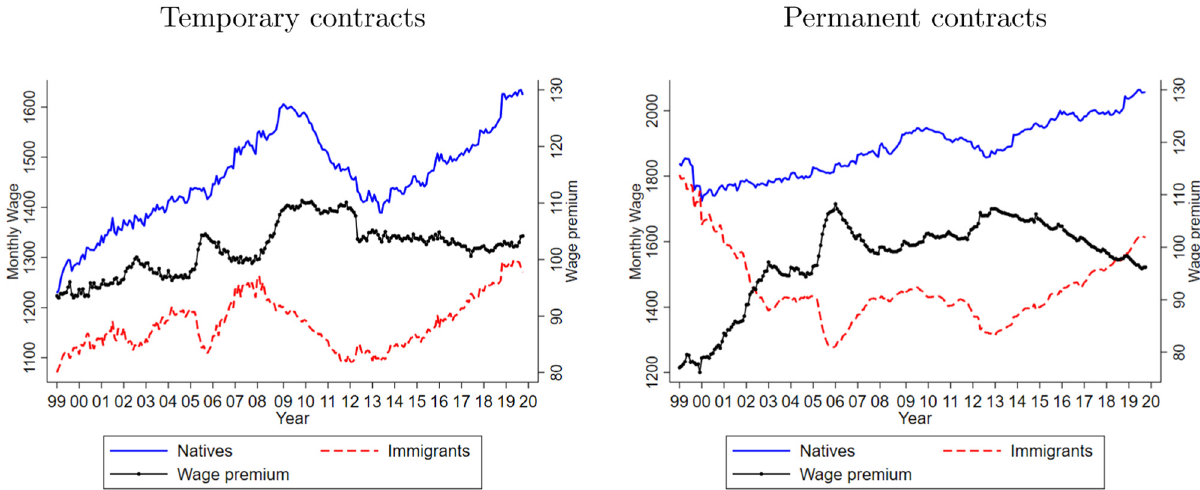
Figure A12: Monthly average wage by nationality and type of contract. Note: The wage premium is computed as ( ) ∕ w w ¯ ¯ − 1 N t M t , , , where w ¯ j t , is the monthly average wage for natives = j N and immigrants = j M at month t . Wage premium is normalised to 100 at Q 2008 1 . Wages are